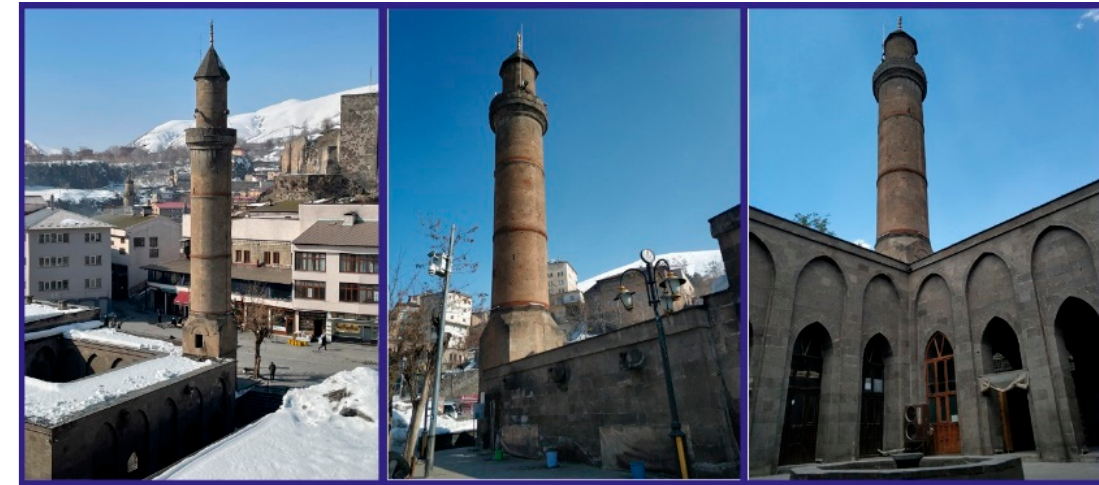
Figure 3. The minaret of the Ulu Mosque.